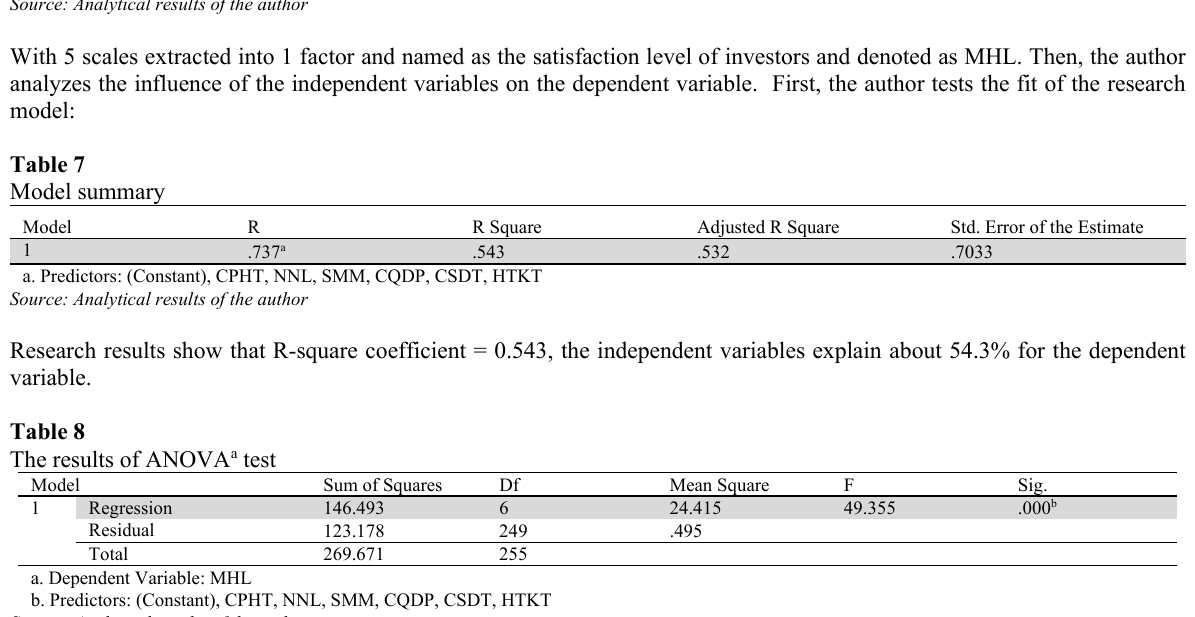
The results of regression analysis Model